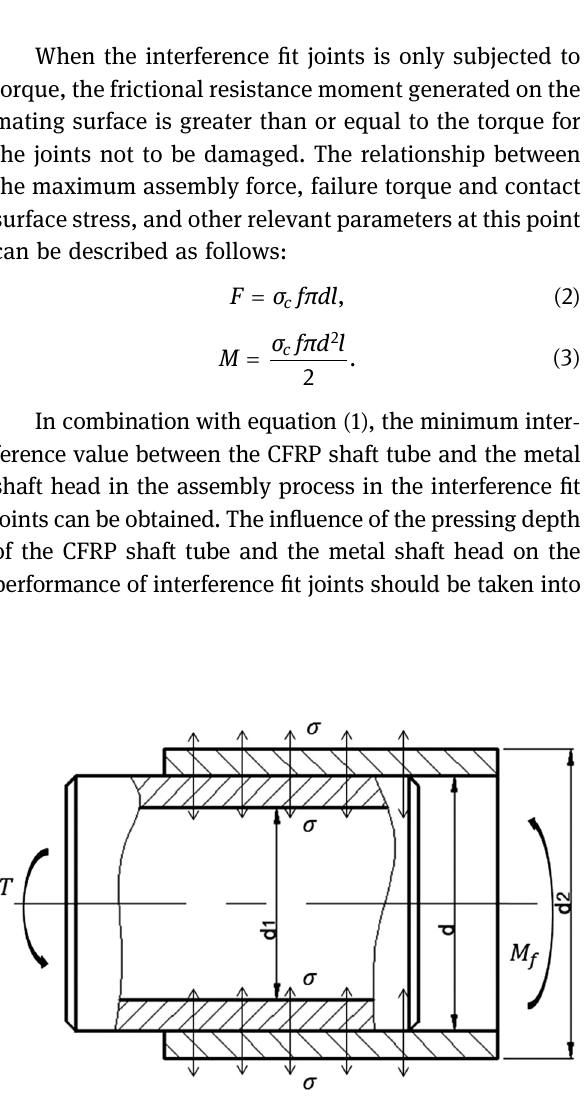
Figure 1: Schematic diagram of the thick - wall cylinder.